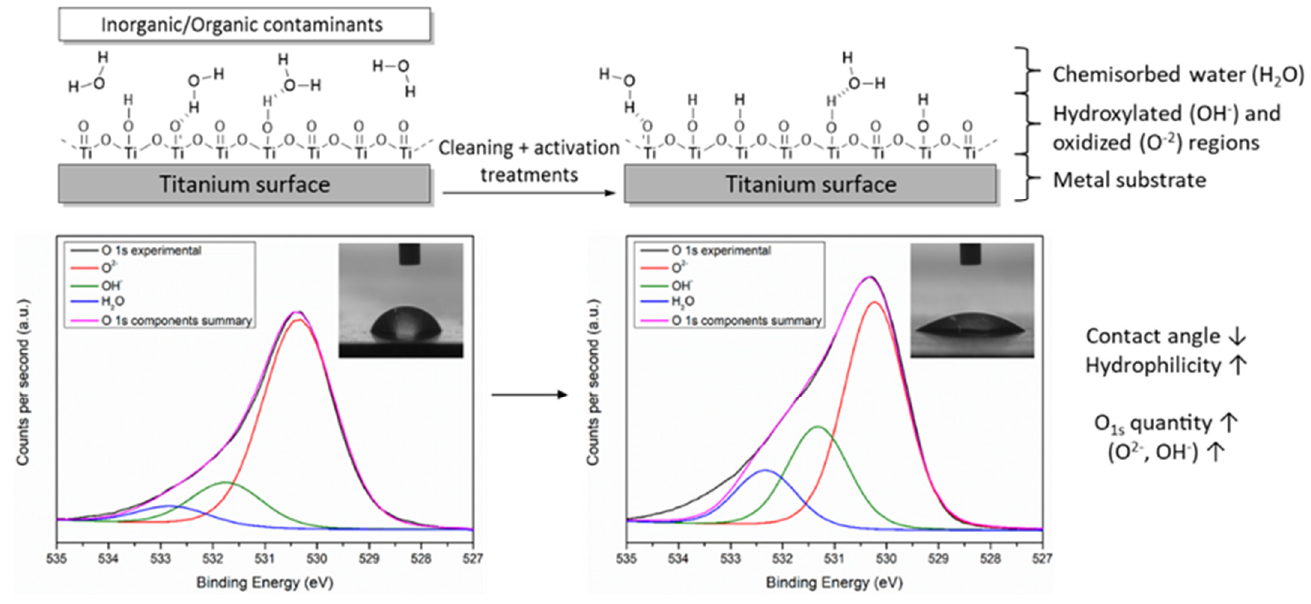
Figure 1. General schematic representation of the layers and chemical components of Ti surfaces before and after cleaning and activation treatments. Contact angle and XPS spectrum of O 1s photopeak narrow-scan with O 2 − , OH − , and H 2 O components are also shown as common characterizations.